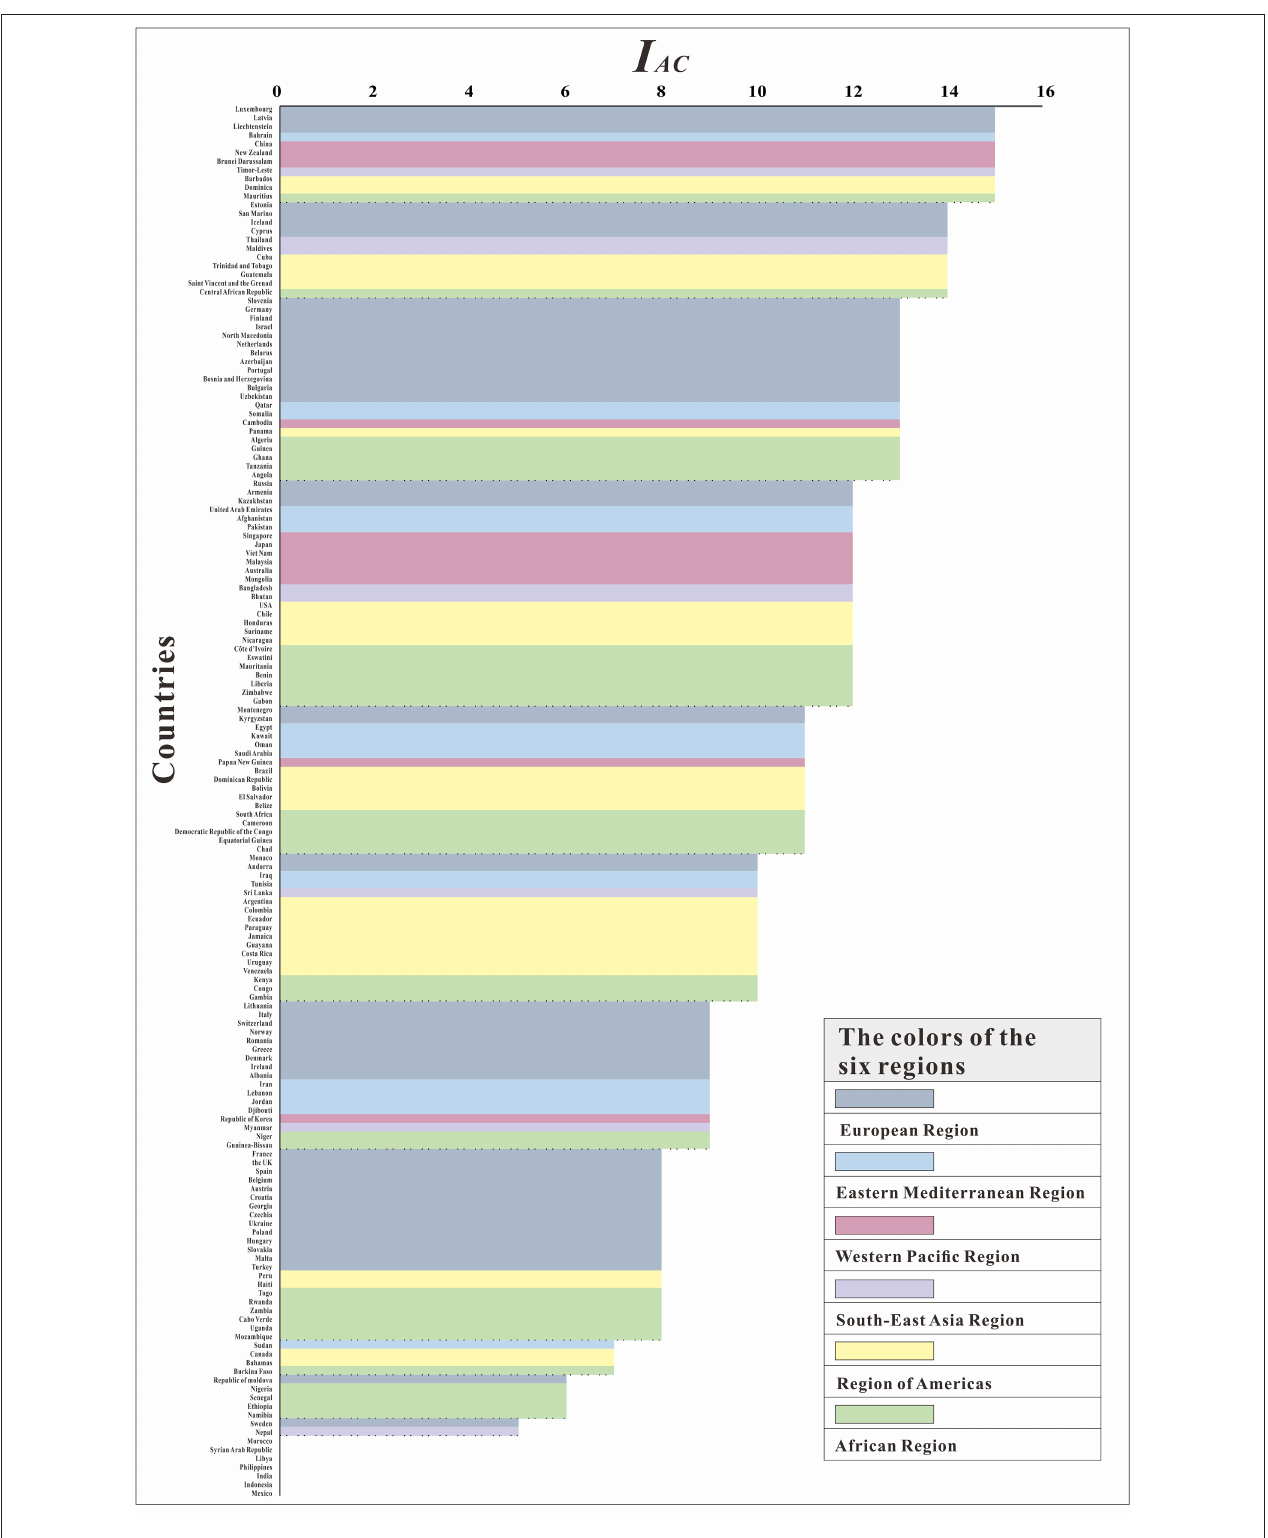
FIGURE 8 | The ranking of I AC among160